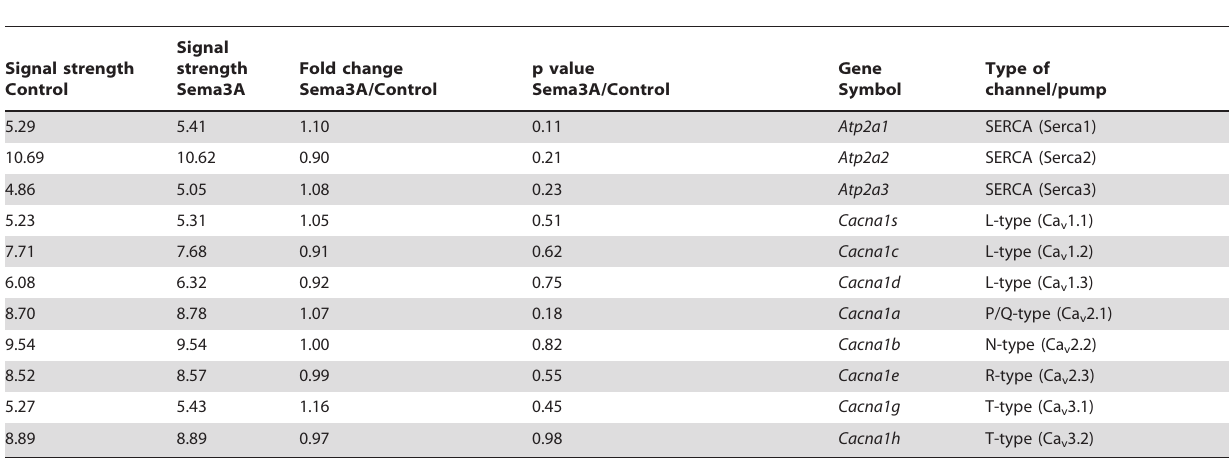
Table 1. Data from gene expression profiling of E15 mouse DRG’s in two different conditions: control conditions (Control), and bath application of 100 ng/mL Sema3A